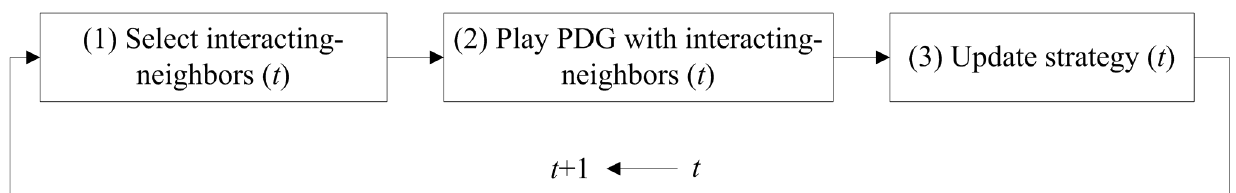
Fig 1. The interacting process of